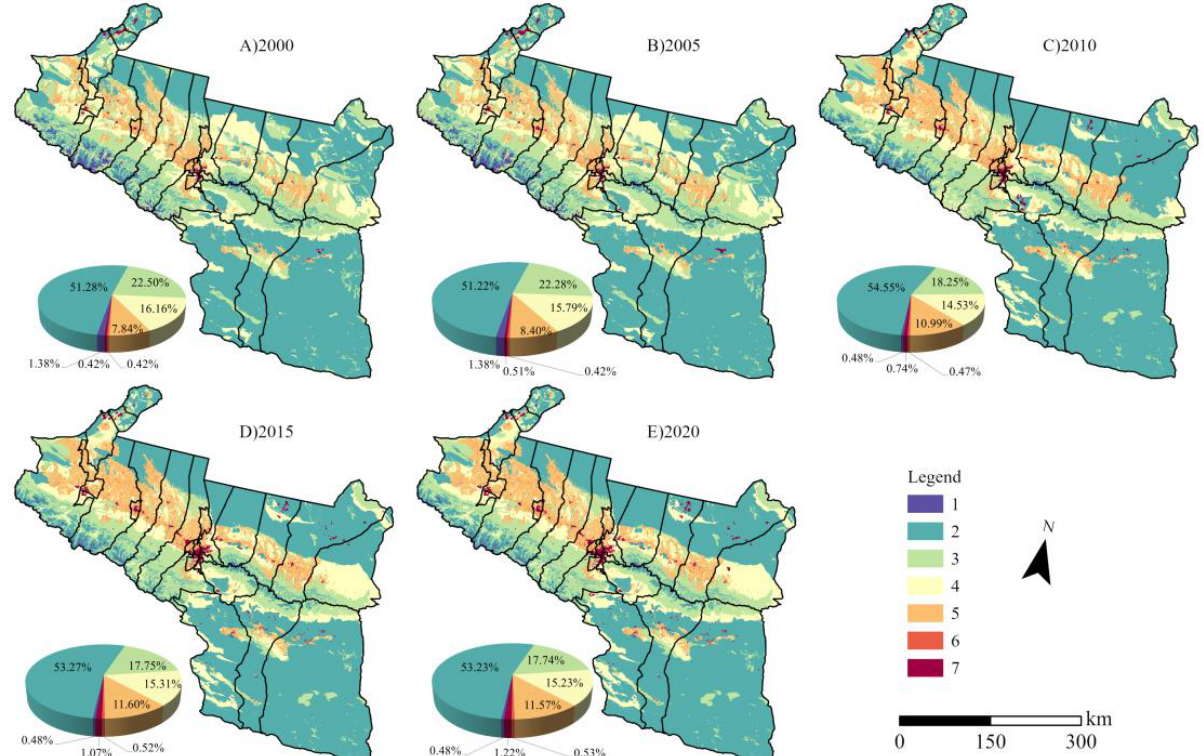
Figure 4. Spatial distribution and statistics of HI per 5 years.